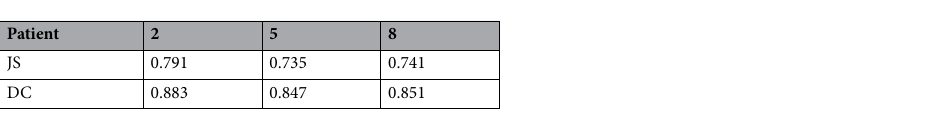
Table 4. Evaluation results of the proposed method on the 3 patients with chemotherapy without considering the treatment.